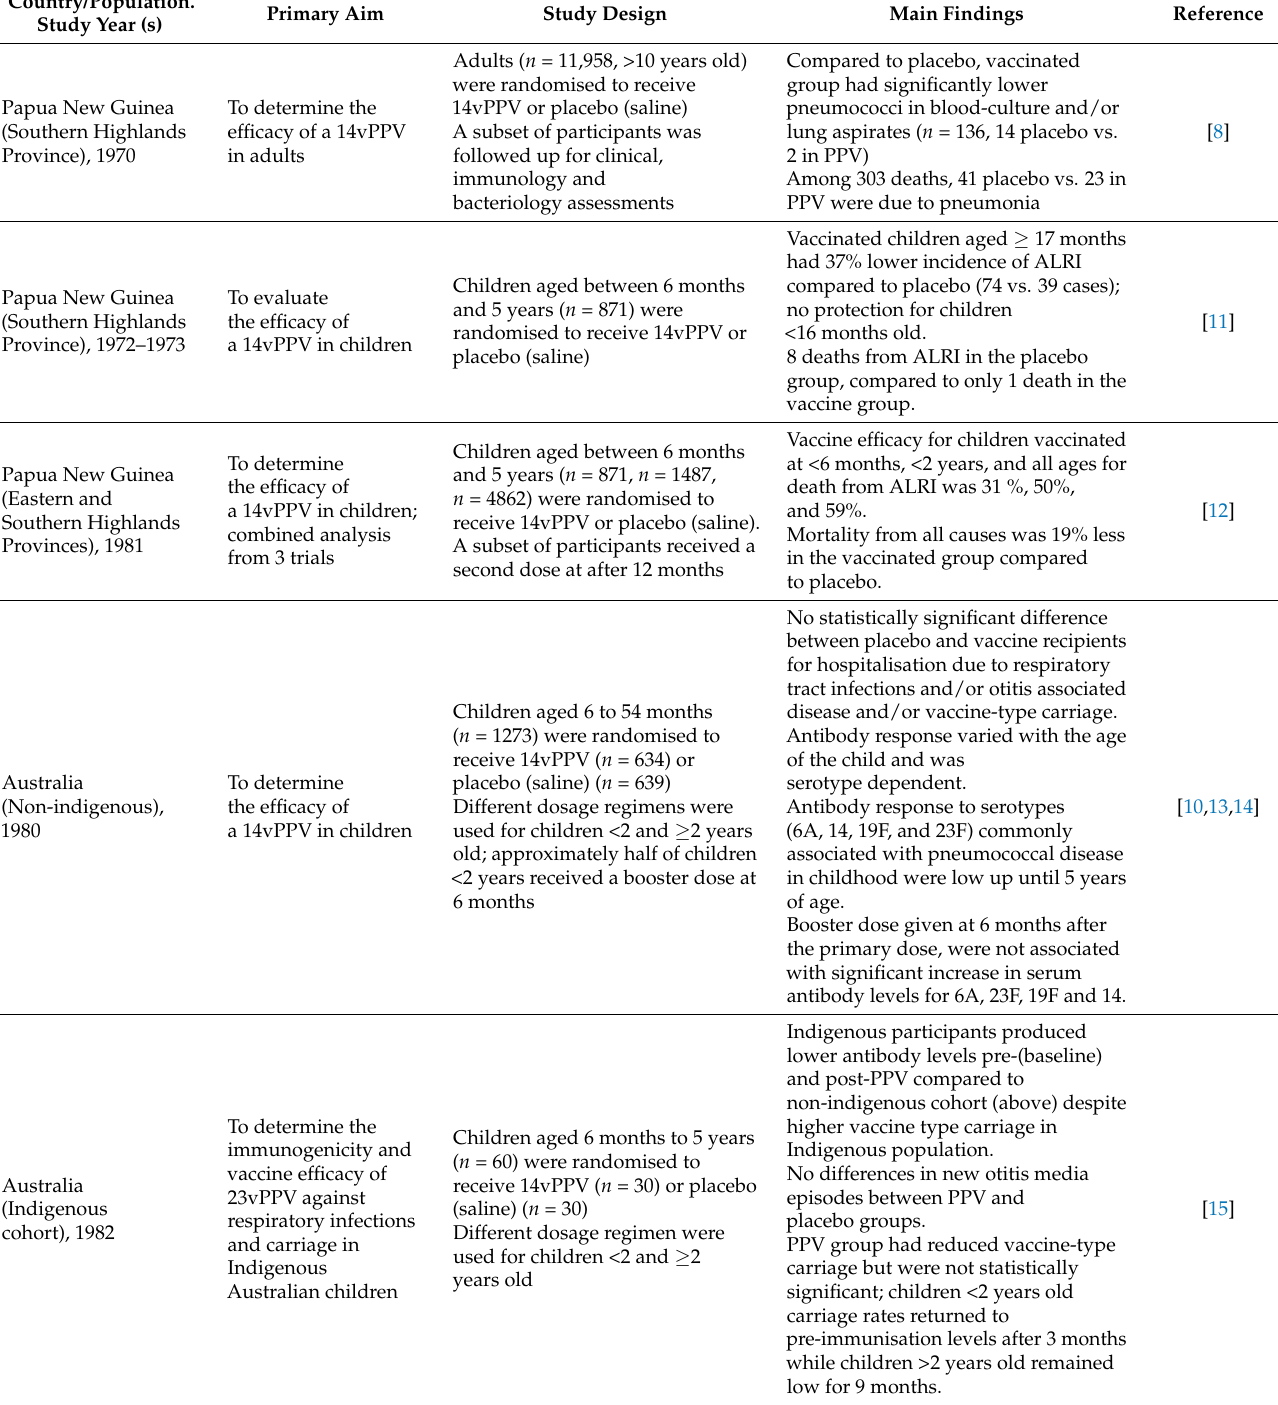
Table 2. Pneumococcal polysaccharide vaccine evaluation